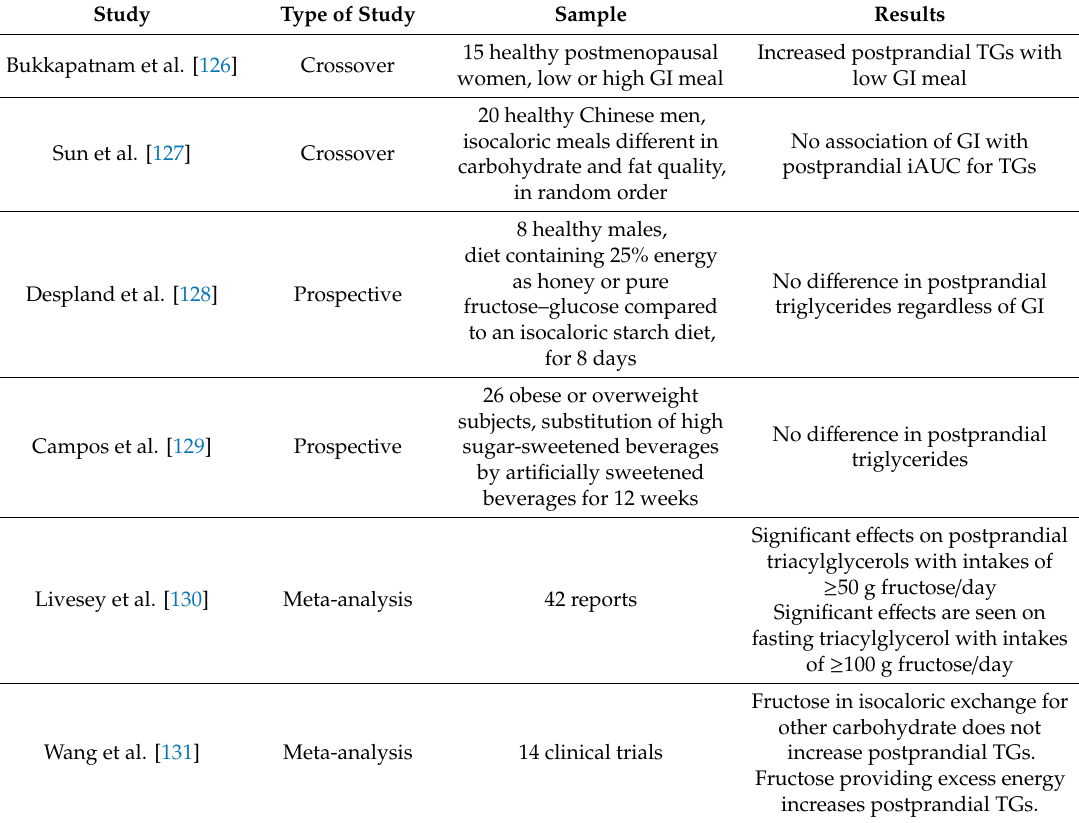
Table 4. Major studies and meta-analyses that suggest no association between glycemic index / glycemic load and postprandial